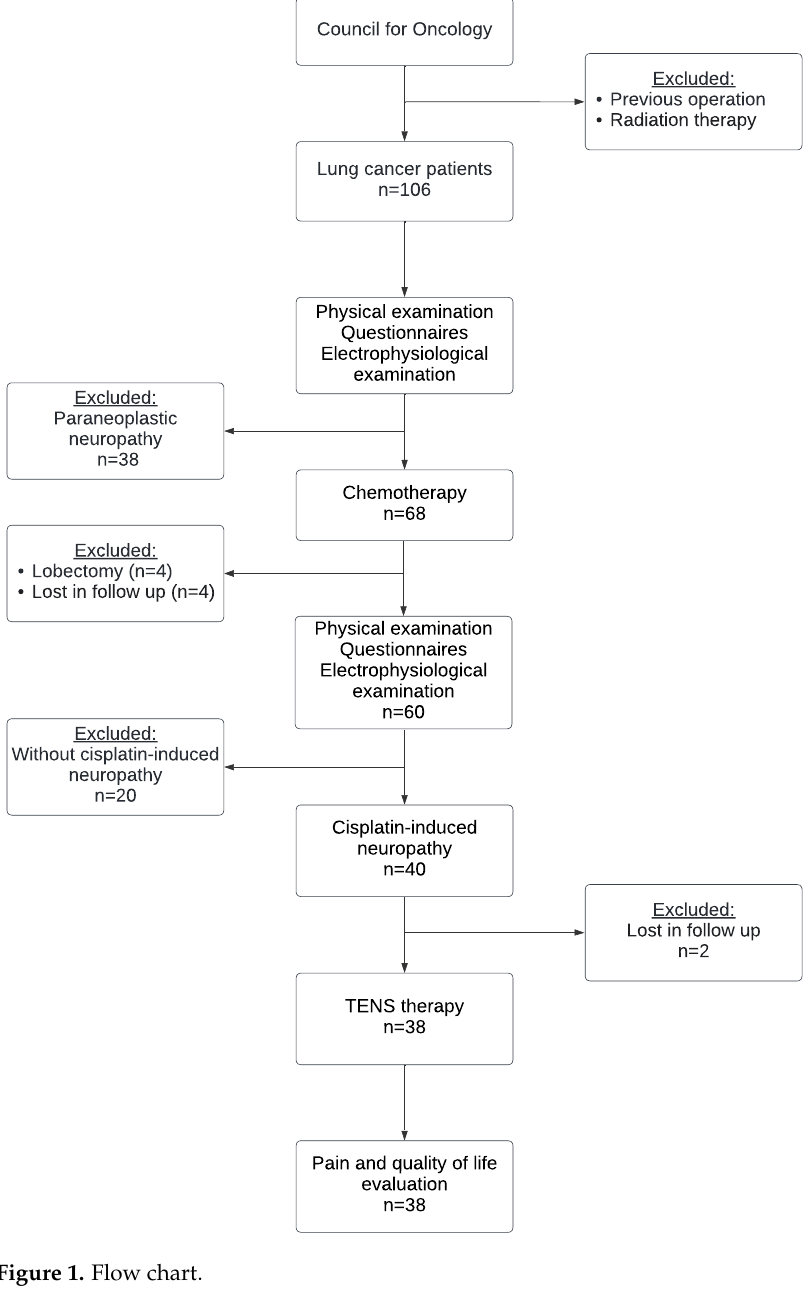
Figure 1. Flow Figure 1. Flow chart.